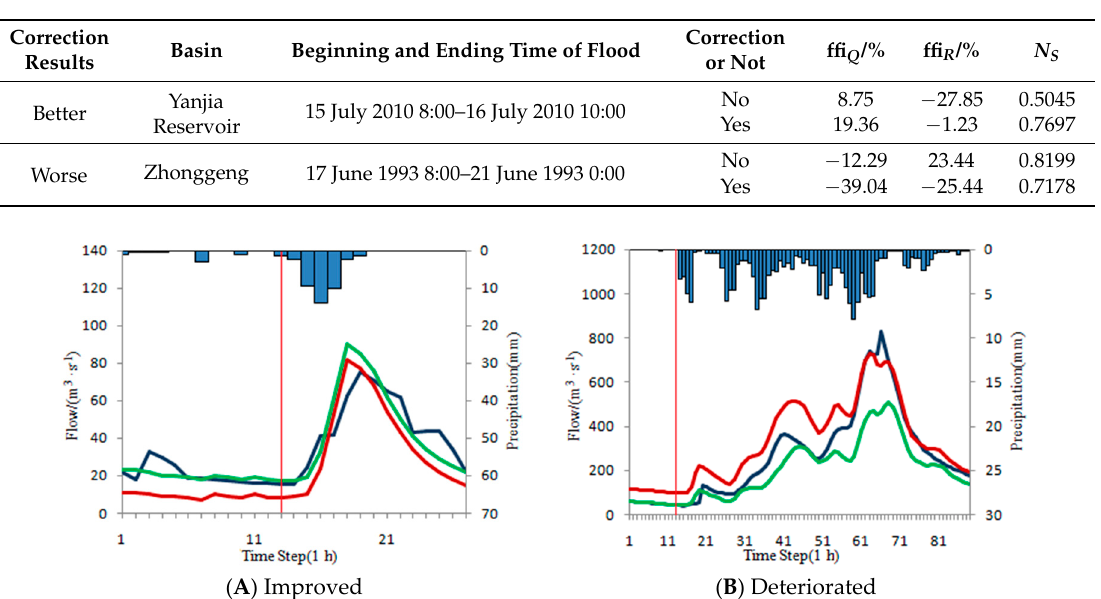
Table 17. Statistics of correction results of complex floods in each basin.